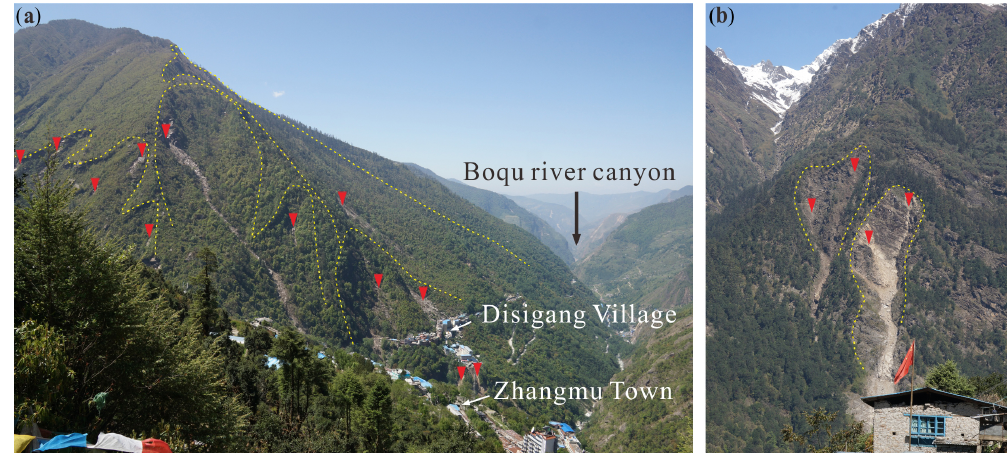
Figure 7. New and old collapses and landslides on both banks of the Boqu River in Zhangmu Town: (a) the east bank and (b) the west bank. The yellow dotted lines show the boundaries of old collapses and landslides. The red triangles denote new collapses during the Nepal